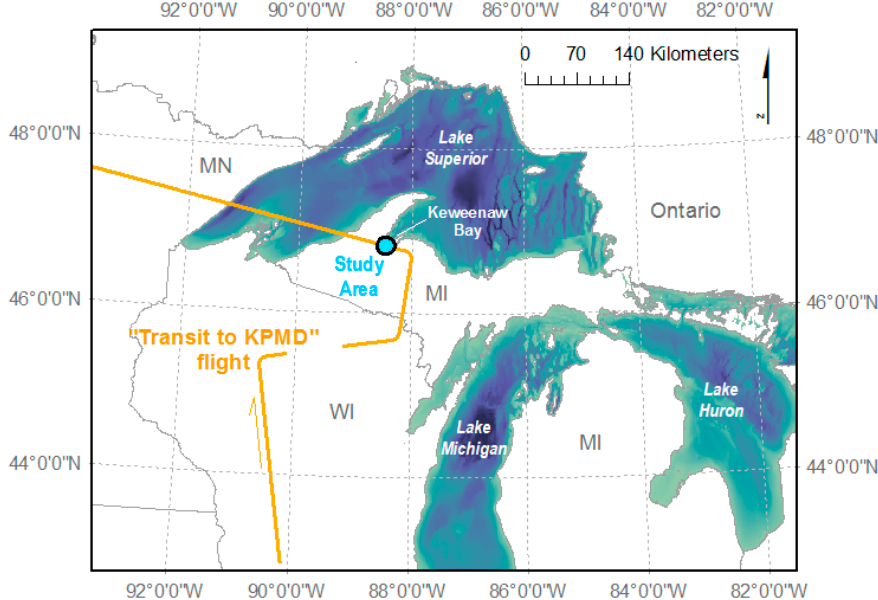
Figure 2. The study site is at the southern end of Keweenaw Bay, Lake Superior, at the eastern base of Michigan’s Keweenaw Peninsula.